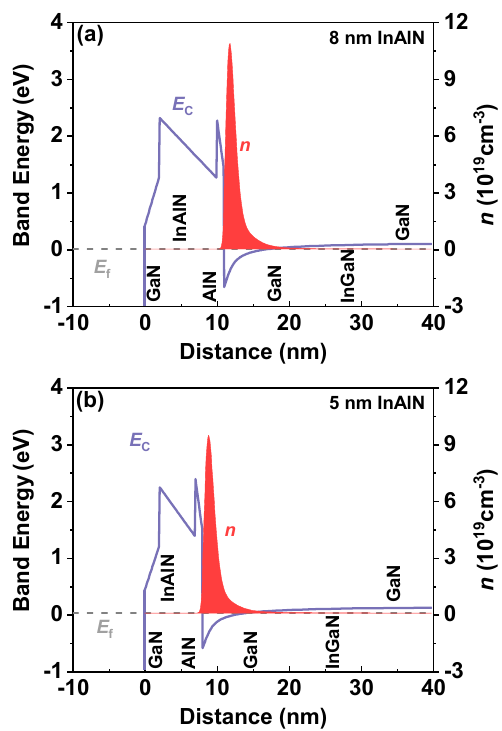
Figure 3. Simulated band structure and 2DEG electron density as a function of the distance from the material surface of the InAlN/GaN heterostructure with ( a ) 8 nm InAlN and ( b ) 5 nm InAlN, respec- tively.